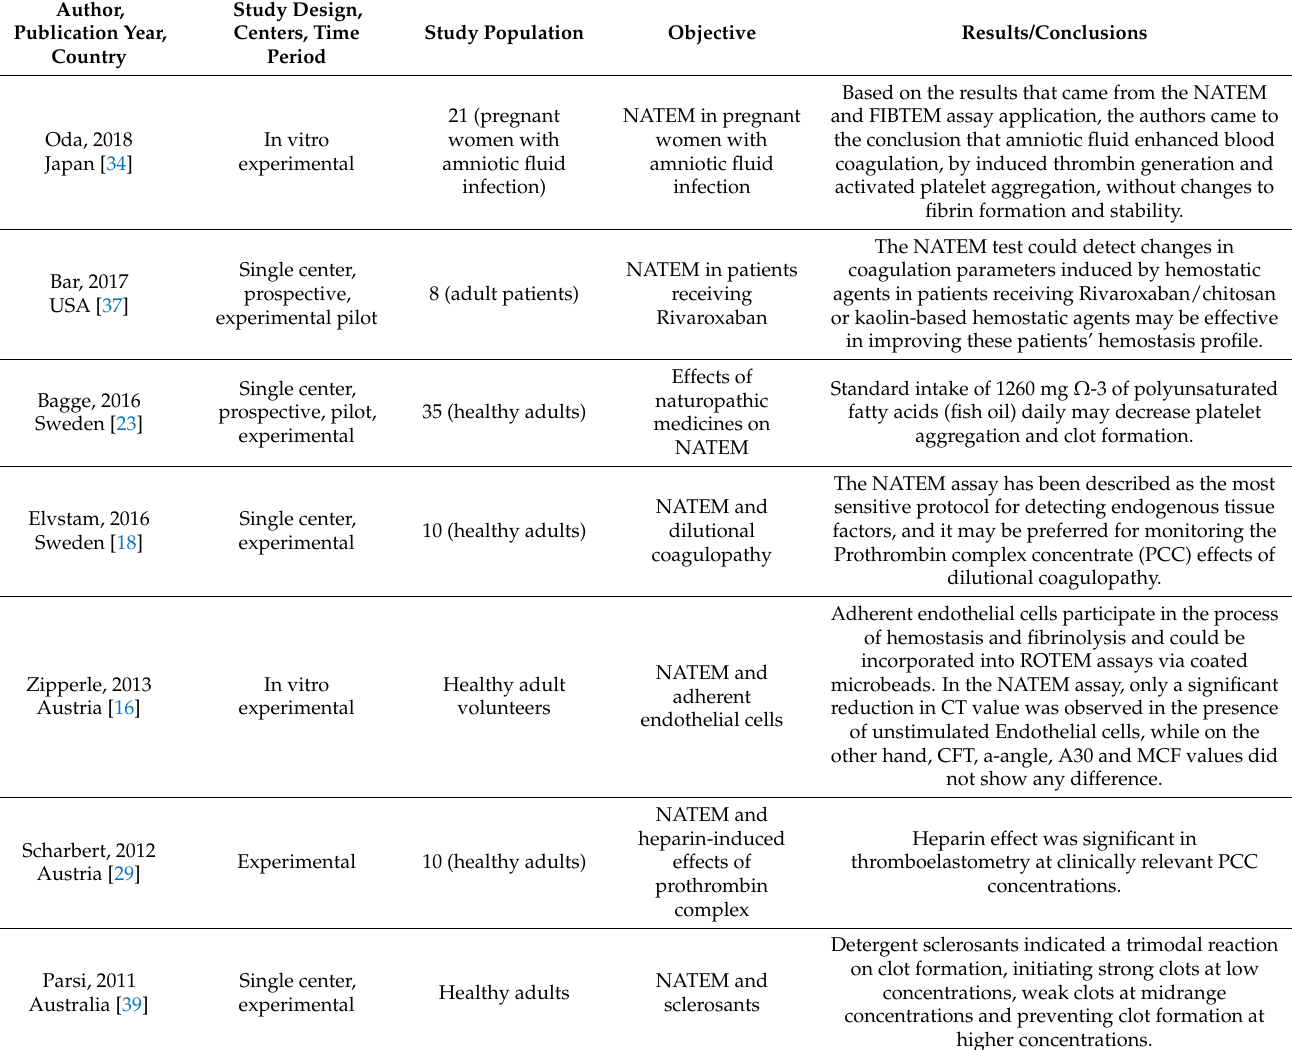
Table 1. Non-activated rotational thromboelastometric (NATEM) assay in experimental